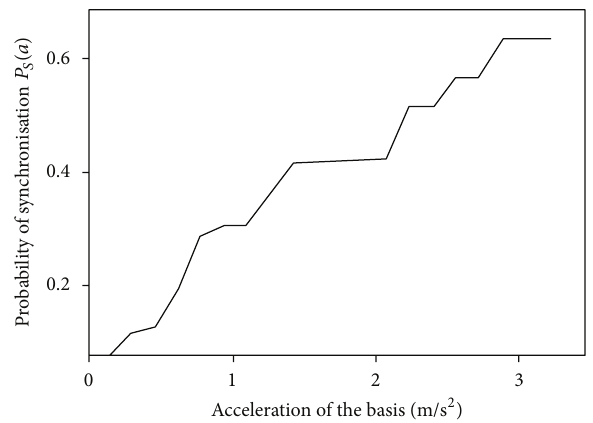
Figure 14: Probability of synchronisation as a function of the acceleration of the bridge